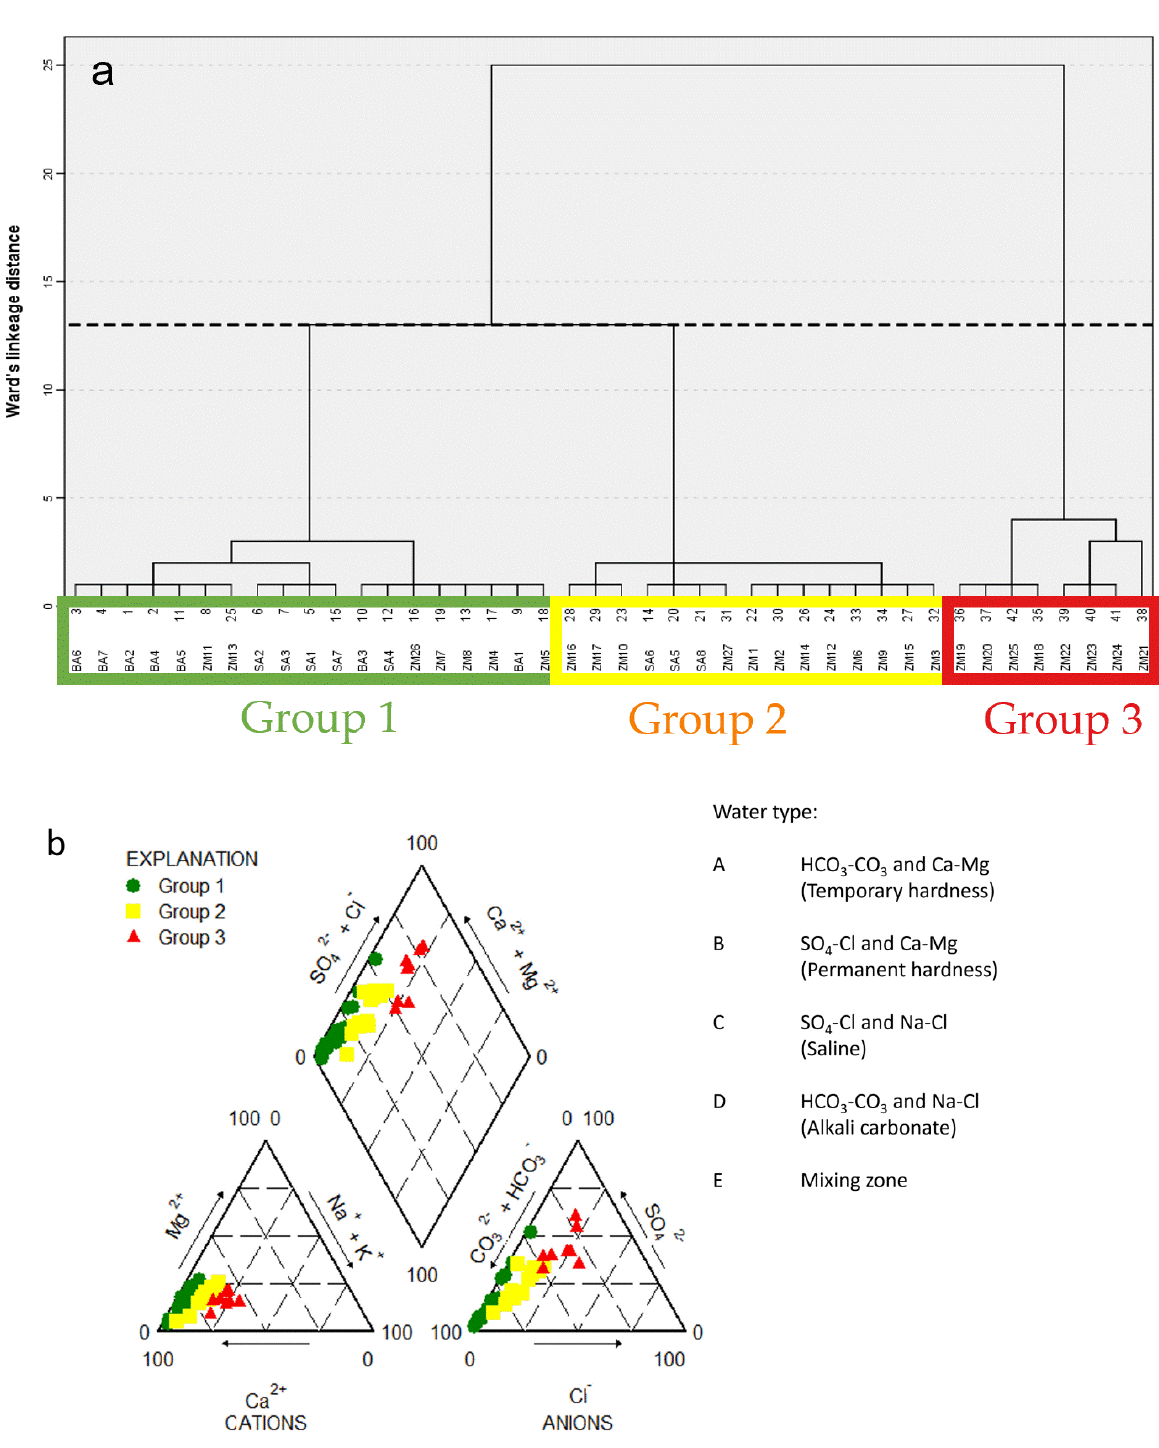
Figure 3. ( a ) Resulting dendrogram of the HCA applied to the MMA groundwater dataset. A phenom line (dashed line) is used to identify the three groups. ( b ) Trilinear diagram showing the different water types in the MMA groundwater.